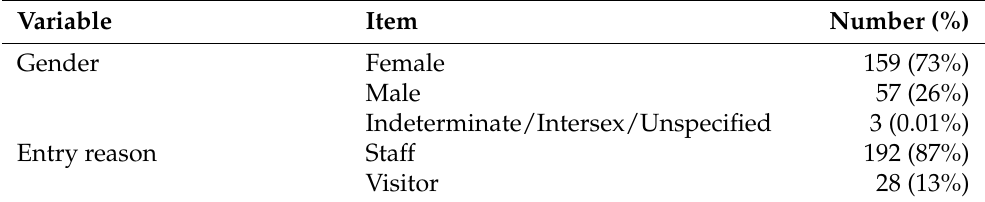
Table 1. Relevant demographic information for the participants in our study.